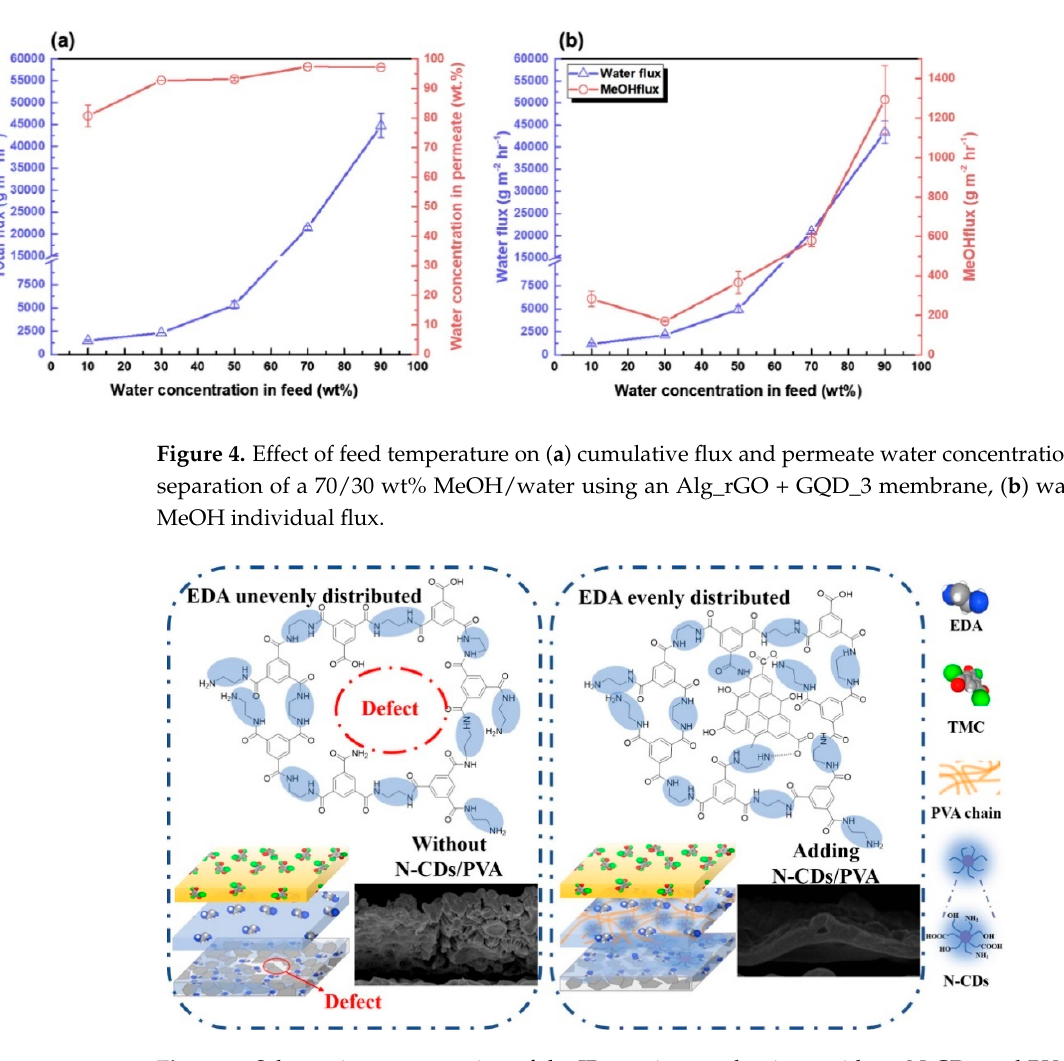
Figure 3. Proposed mechanism of sealing structural defects using Graphene Quantum Dots (GQD).